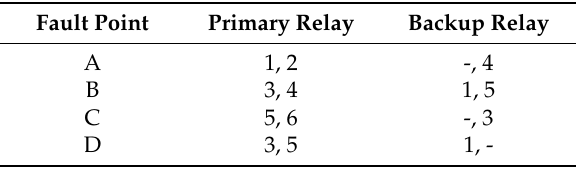
Table 14. Primary and backup relationships of the relays for Case IV.